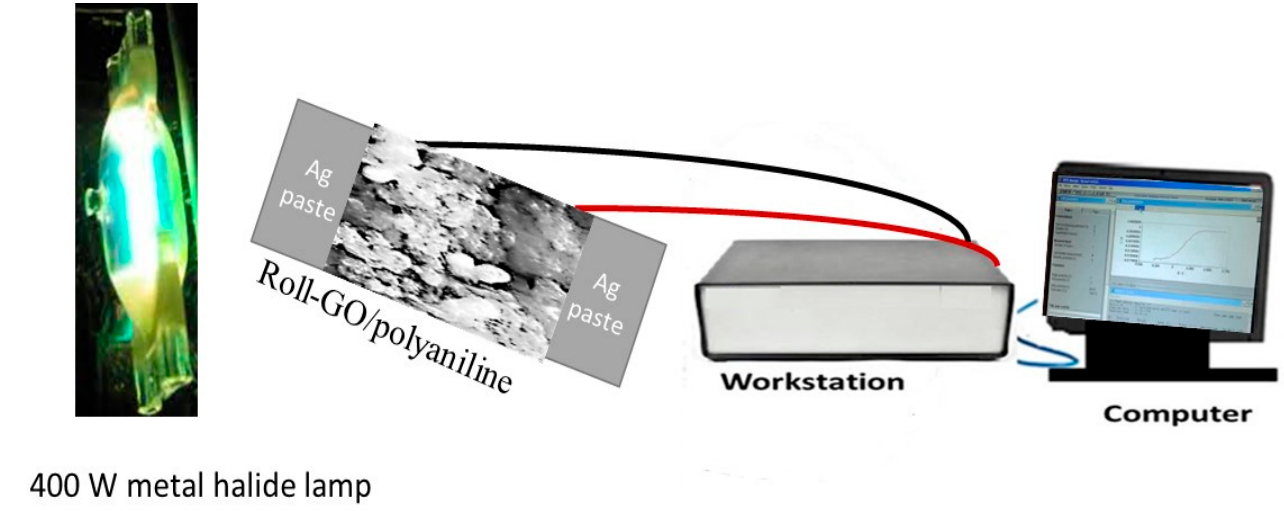
Figure 1. The electrical testing of roll-GO/PANI as a photodetector.